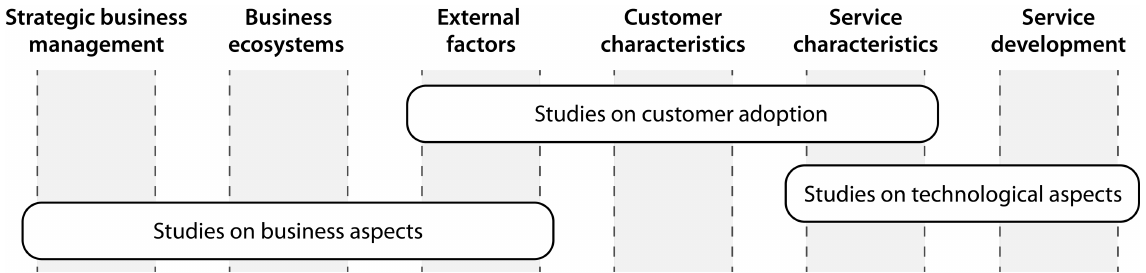
Fig. 10. Research focus and the main themes of mobile payments